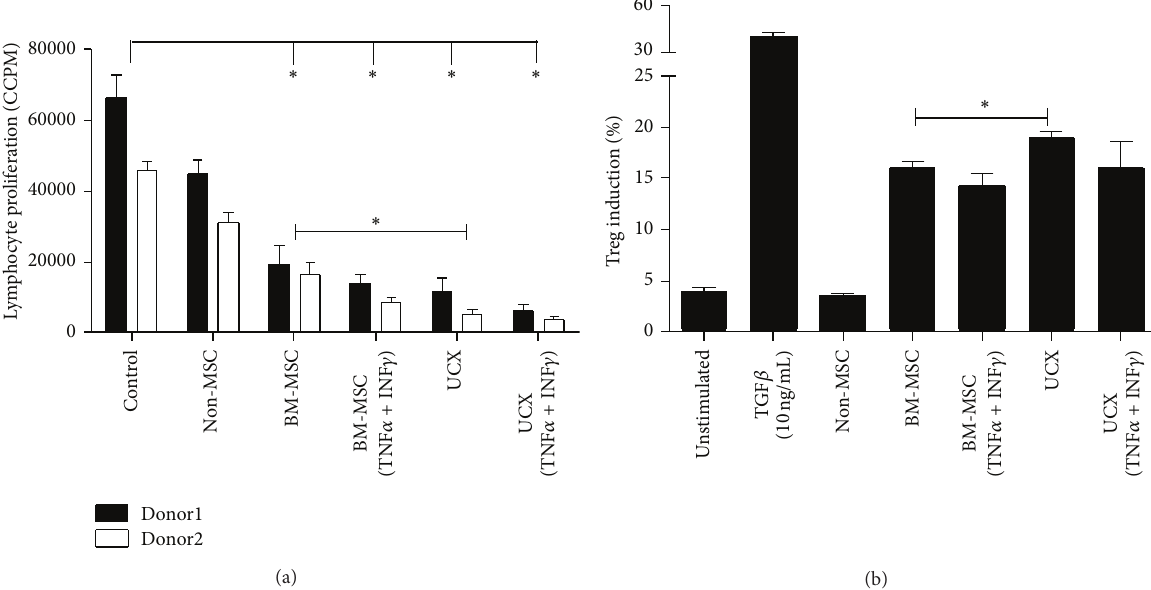
Figure 3: UCX are more potent immunosuppressors than BM-MSCs. (a) Activation of PBMCs from two different donors was induced by incubation with anti-CD3, anti-CD28, and IL-2 (control). Suppression of lymphocyte proliferation was analysed in the presence of irradiated non-MSCs (Molt4), BM-MSCs, and UCX (both na¨ıve and primed with 10 ng/mL of TNF 𝛼 and IFN 𝛾 ). Independent of donor, lymphocyte proliferation was significantly suppressed when cells were cocultured with MSCs, but not with non-MSCs. Values are represented as mean ± s.e.m. and statistically significant differences are indicated by asterisks (nonparametric 𝑡 -test Mann Whitney, ∗ 𝑃 < 0.05 ). (b) Treg conversion was assayed by using FACS-sorted CD3 + CD4 + CD25 − T cells that were activated with anti-CD3, anti-CD28, and IL-2 alone and with the addition of TGF- 𝛽 . The effect of irradiated UCX and BM-MSCs in T cell conversion was analysed in cultures without exogenous TGF- 𝛽 by flow cytometry analysis of CD25 and Foxp3 expression. Values are represented as mean ± s.e.m. and statistically significant differences are indicated by asterisks (unpaired 𝑡 -test, ∗ 𝑃 < 0.05